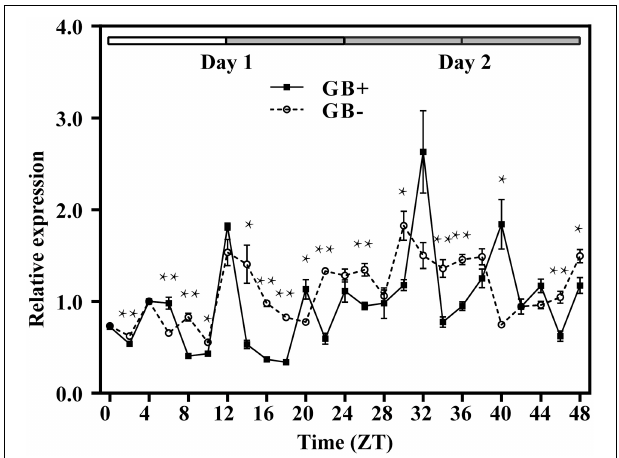
FIGURE 3 | Rhythmic expression of GUS driven by the upstream fragment of the QH6 promoter immediately before (GB + ) or after (GB − ) the G-box motif. Arabidopsis thaliana plants were transformed by GB + or GB − constructs. The steady-state level of GUS transcripts was quantified by real-time PCR, using Actin8 as a reference gene. Leaves were sampled in triplicate for two continuous days, with the first day in standard 12h/12h light/dark cycle and the second day in constant dark. ZT is Zeitgeber time and here represents time from light on at dawn. Filled and open bars indicate subjective days and nights. Data represent means ± SD. The differences of expression levels were assessed by unpaired Student’s t -test. * p < 0 . 05 and ** p < 0 . 01 in GB + vs. GB − transgenic Col-0